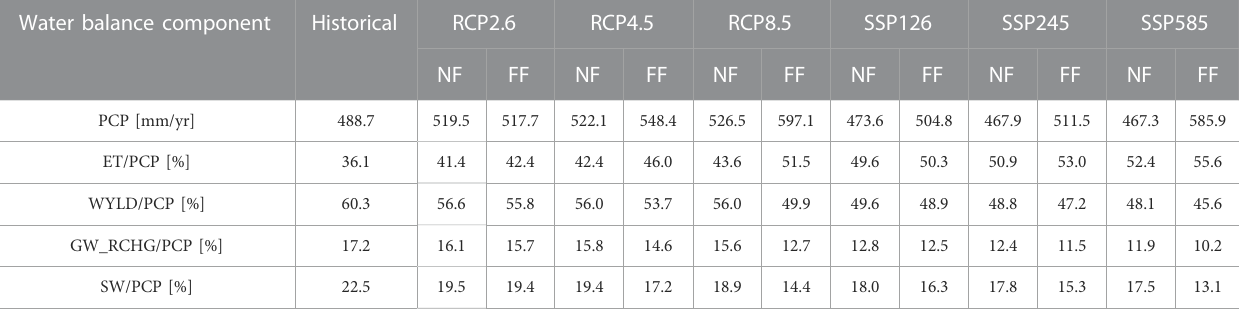
TABLE 4 Water balance component statistics, including in fl ow precipitation and out fl ow evaporation, water yield, groundwater recharge, soil water content, and their percentages of precipitation in historical, CMIP5 (RCP2.6, RCP4.5, RCP8.5), and CMIP6 (SSP126, SSP245, SSP585) scenarios in NF and FF. Water balance